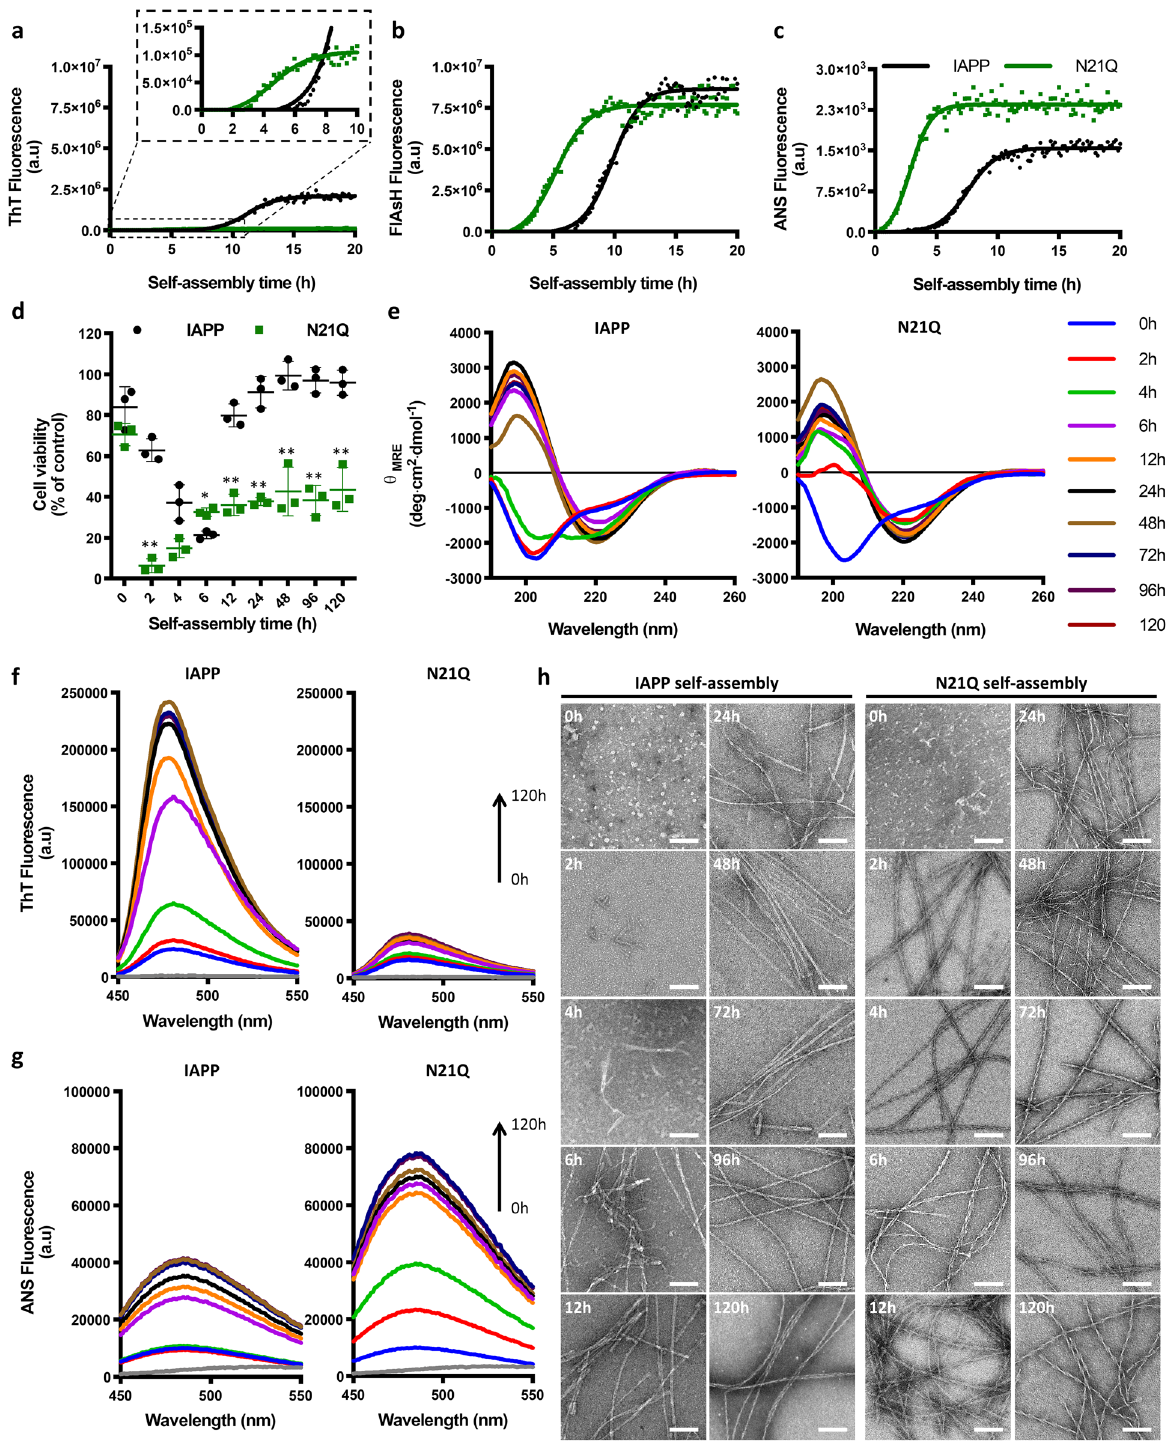
Fig. 4 Kinetics of self-assembly and time-resolved analysis of cytotoxicity. a – c Kinetics of self-assembly monitored by a ThT, b FlAsH, and c ANS fl uorescence. Monomerized peptides were incubated at 12.5 μ M under quiescent conditions in 20 mM Tris-HCl buffer, pH 7.4 in the presence of ThT (40 μ M), FlAsH (0.5 μ M) or ANS (50 μ M). Fluorescence of ThT (Ex 440 nm, Em 485 nm), FlAsH (Ex 508 nm, Em 533 nm) and ANS (Ex 355 nm, Em 480 nm) was measured every 10 min. Data from triplicates were averaged and fi tted with a Boltzmann sigmoidal curve. d Time-resolved cytotoxicity of proteospecies evaluated by measuring the metabolic activity of INS-1E upon 5 h incubation with 50 μ M pre-assembled peptides. e – h Time-resolved self- assembly of IAPP and N21Q monitored by e CD spectroscopy, f ThT fl uorescence, g ANS fl uorescence and h TEM. d – h Freshly dissolved monomerized peptides were incubated under quiescent conditions at 150 µ M in 20 mM Tris-HCl buffer, pH 7.4 and after the indicated time of self-assembly, the aggregation mixture was characterized and evaluated for cell